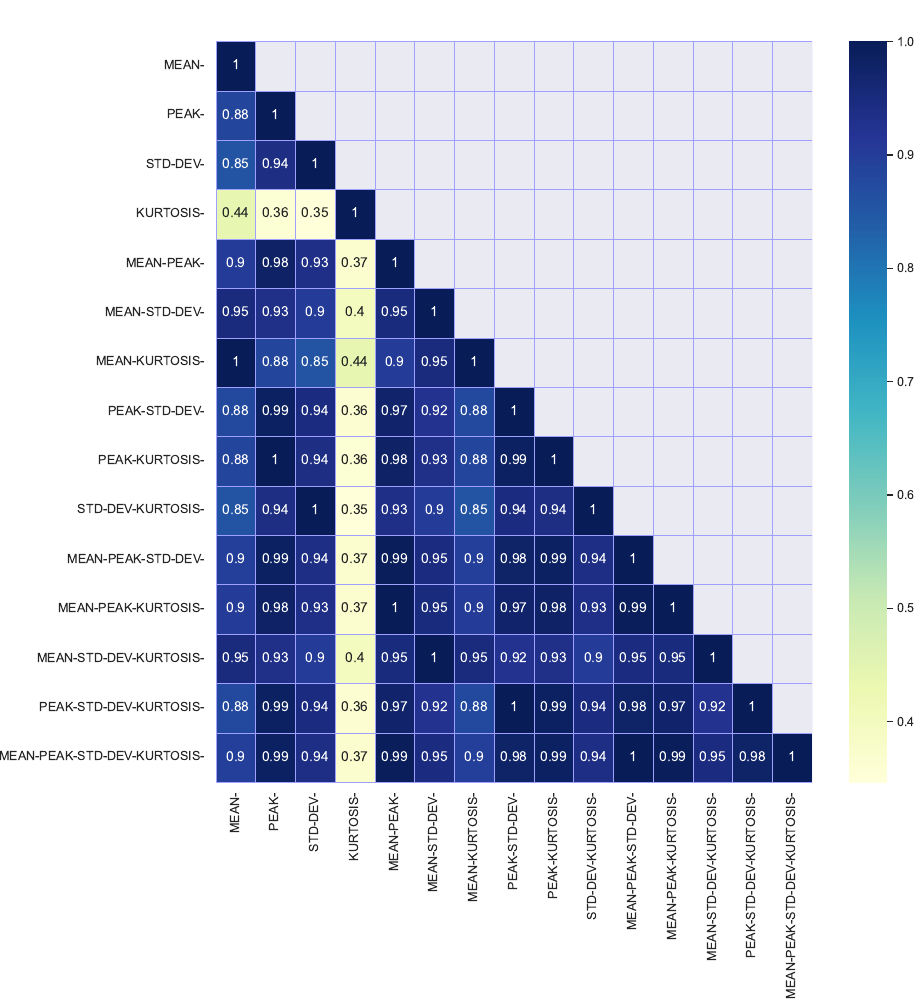
Figure 10. Heatmap of classification coincidences between clustering of each combination of geomet- ric indicators.